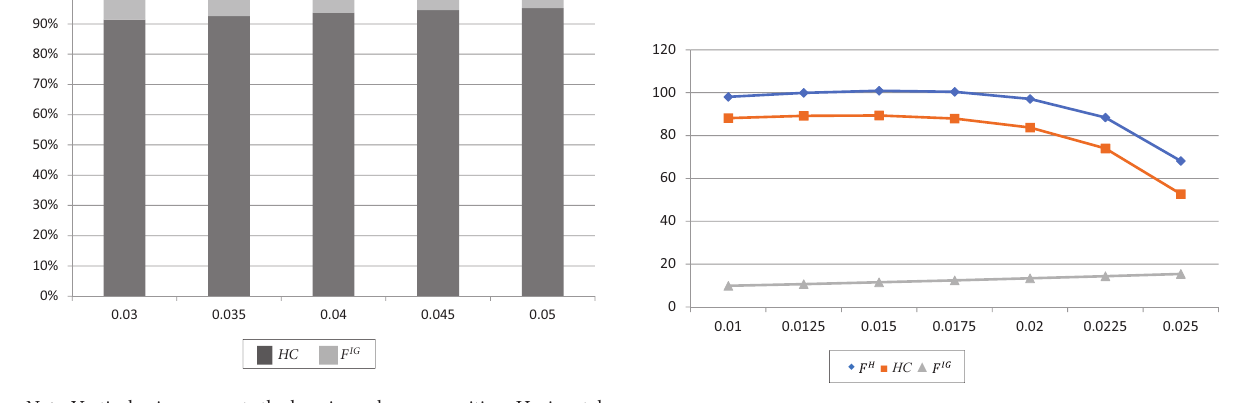
Figure 4. Risk-free rate and housing